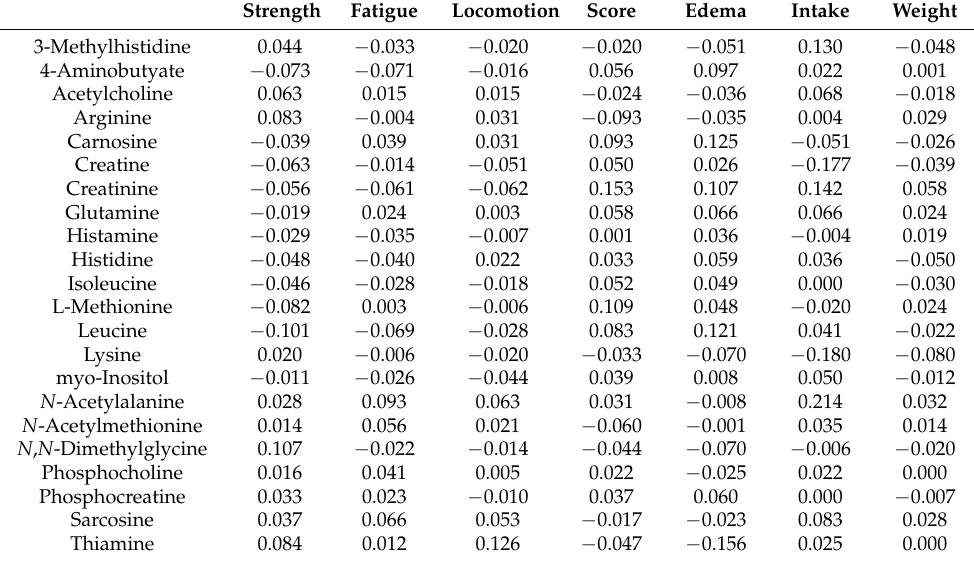
Table 4. Regression analysis between clinical data and metabolic profile found in urine and identified by BML. Metabolites shown are solely the ones related to muscle loss process. Value expresses the metabolite contribution to the model. Strength Fatigue Locomotion Score Edema Intake